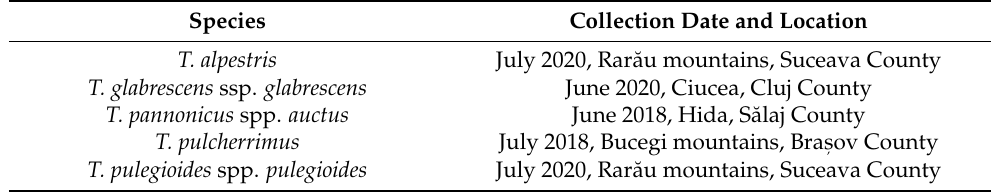
Table 1. Identification data for Thymus samples